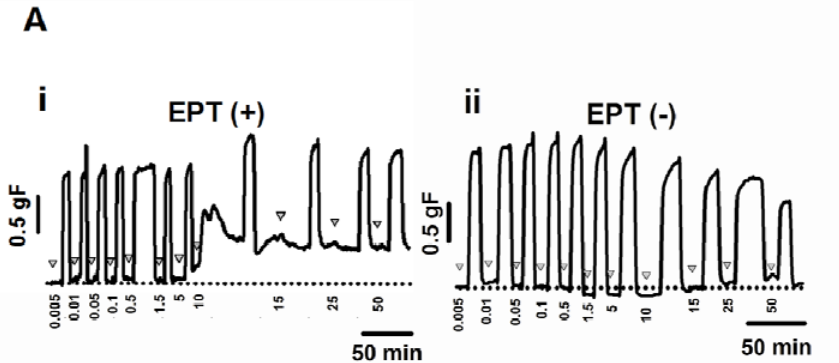
Figure 3. Representative experimental tracings showing the inhibitory effects of non-cumulative increasing concentrations (0.005–50 mM) of trans -caryophyllene on the ACh-induced contractions in rat isolated trachea with (EPT(+), Ai ; n = 6) and without (EPT( − ), Aii ; n = 8) intact epithelium. Inverted triangles indicate drug application. ( B ) Concentration-response curves of the relaxant actions of trans -caryophyllene. Closed triangles represent segments with intact epithelium and closed circles without intact epithelium. Symbols are means ± S.E.M. ( C ) Average values for relative IC 50